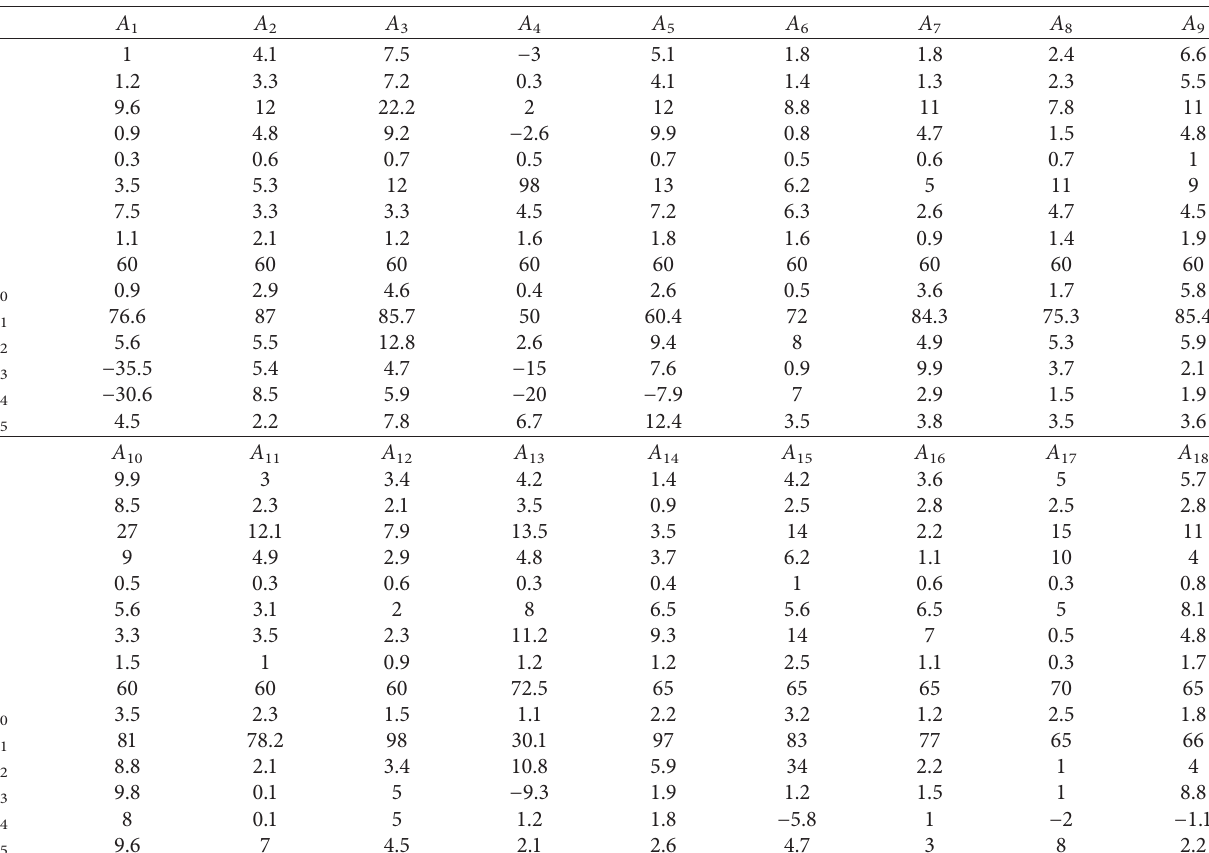
Table 2: Financial index data of various